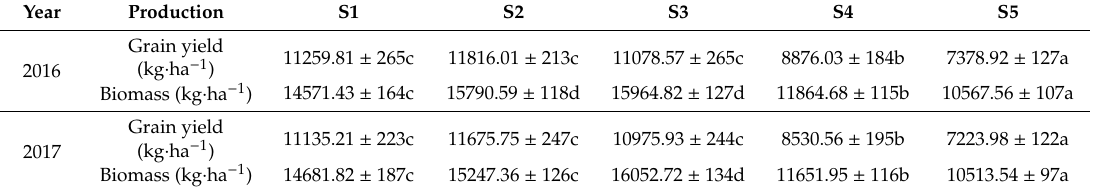
Table 8. Irrigation water salinity e ff ects on grain yield and maize biomass.